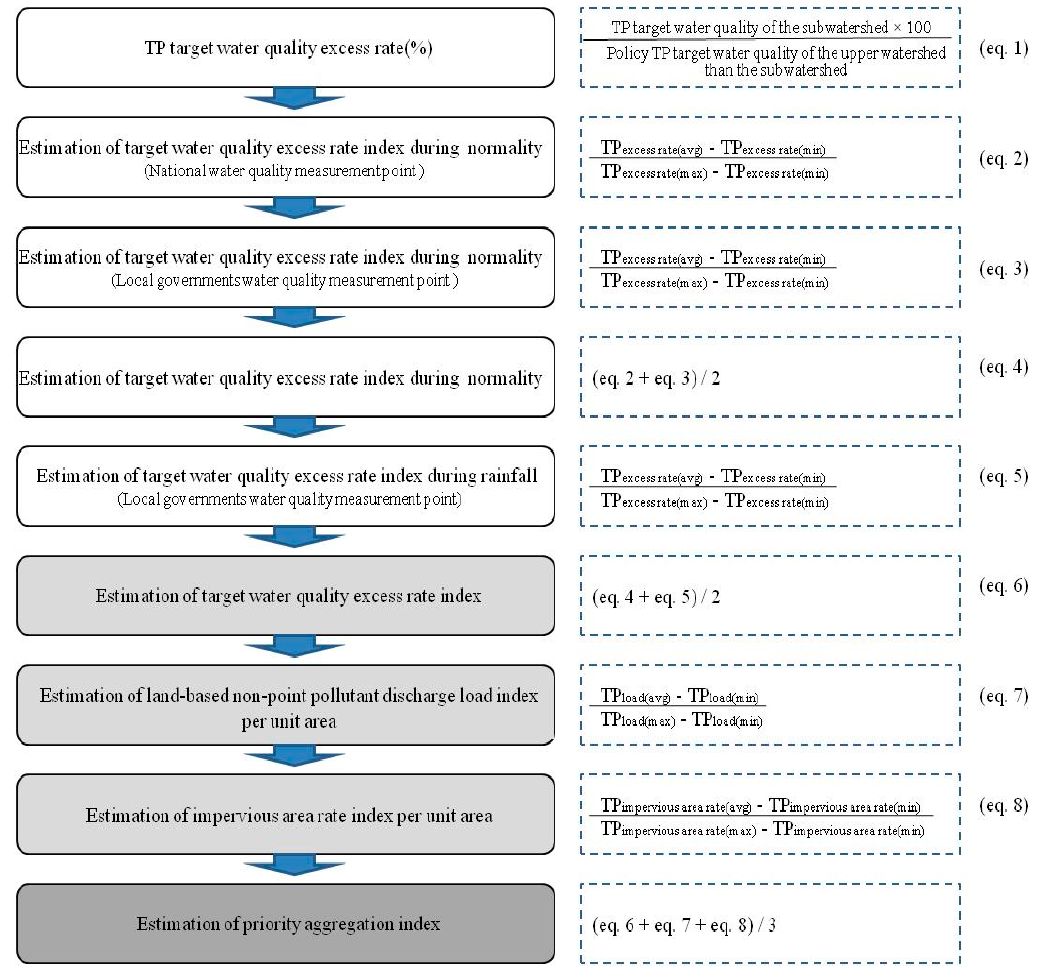
Figure 6. TP (total phosphorus) priority integration index calculation procedure.